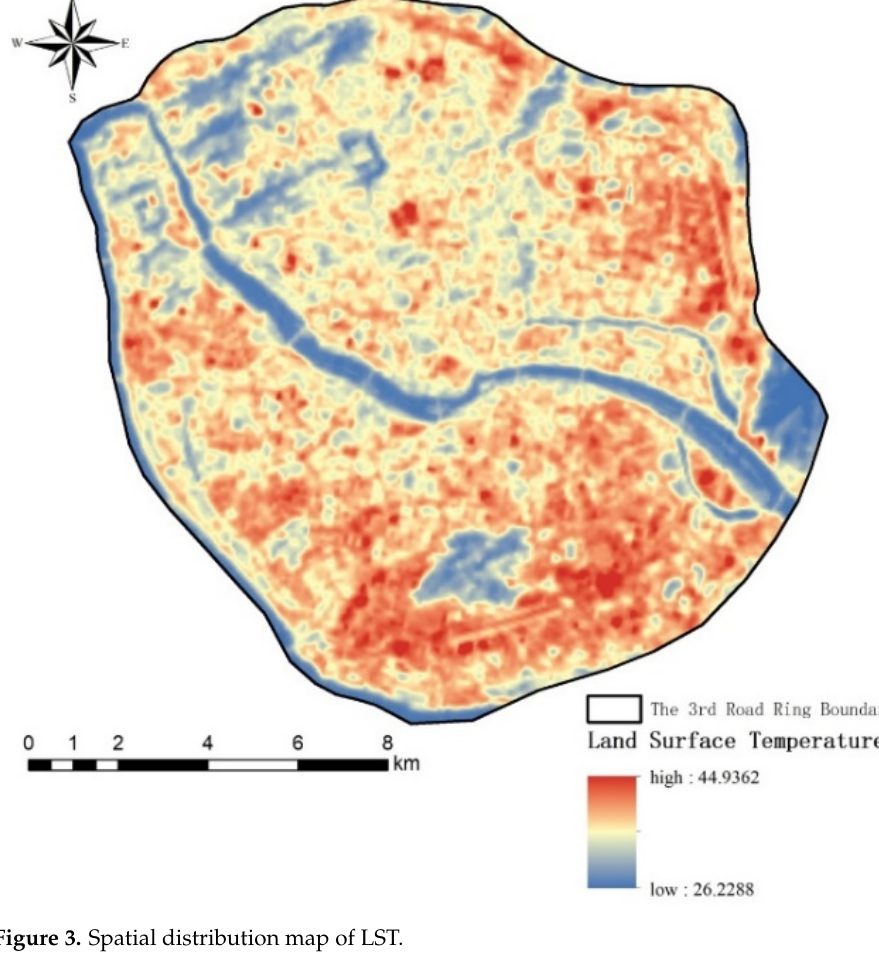
Figure 3. Spatial distribution map of LST.